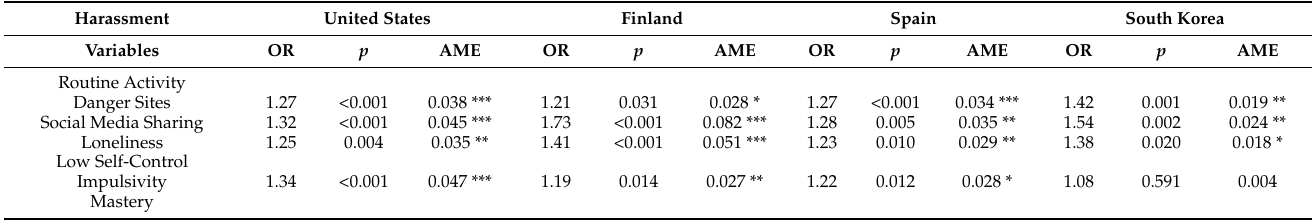
Table 3. Logistic regression country tables for cyberharassment victimization by type of routine activity, low self-control, sense of mastery, and control